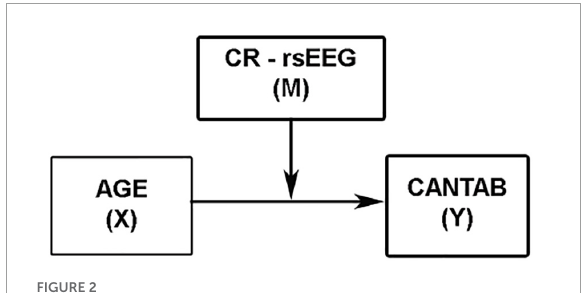
FIGURE2 Conceptual representation of the simple moderation model.